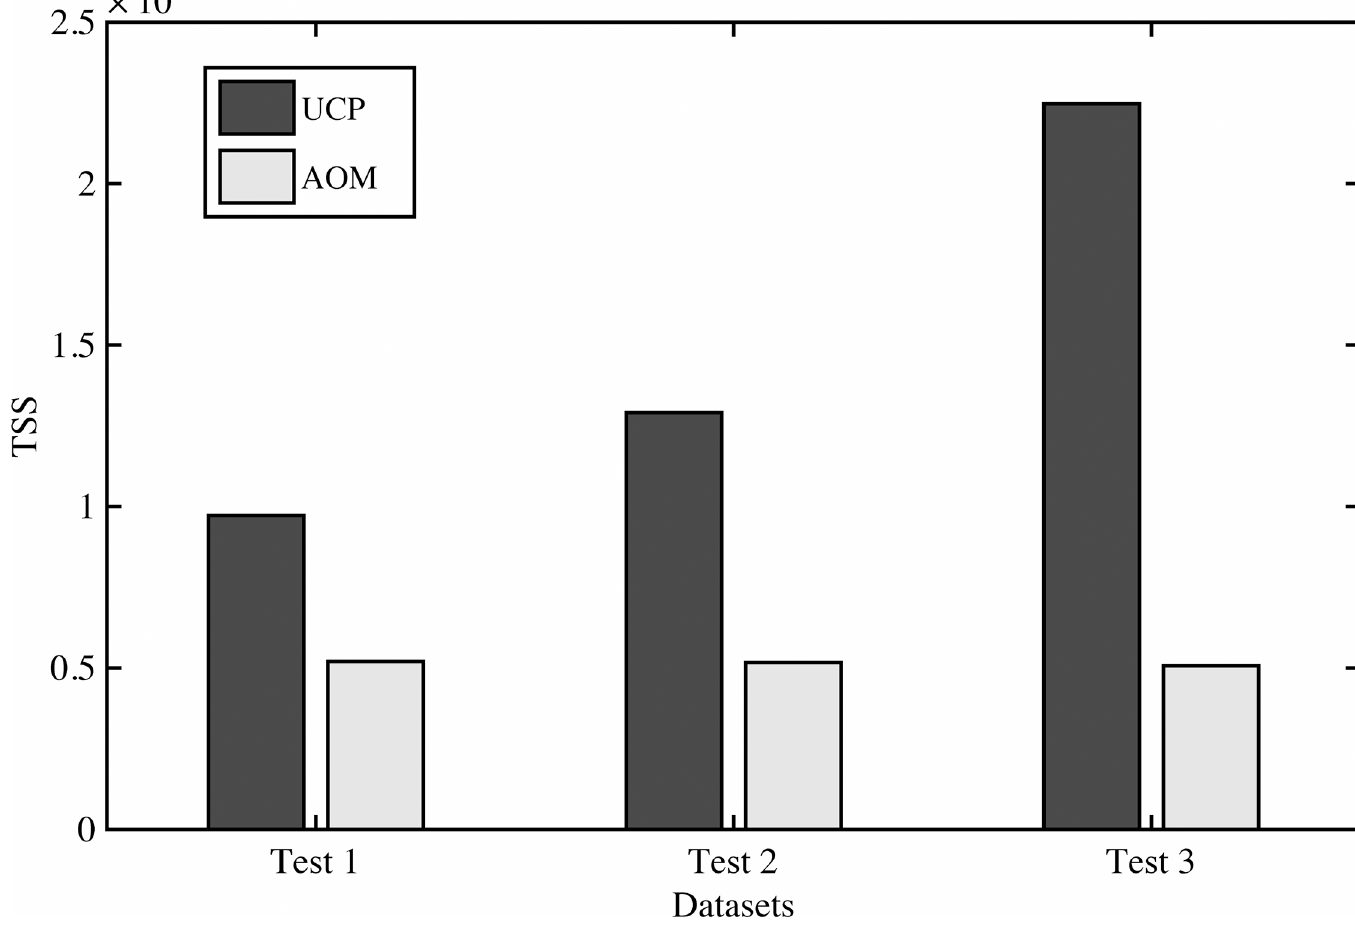
Fig 4. Total Sum of Squares.